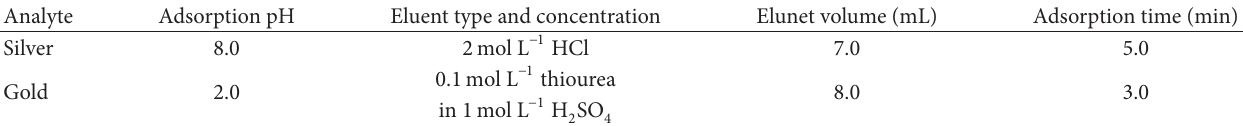
T 4: e optimum conditions for extraction of gold and silver ions.